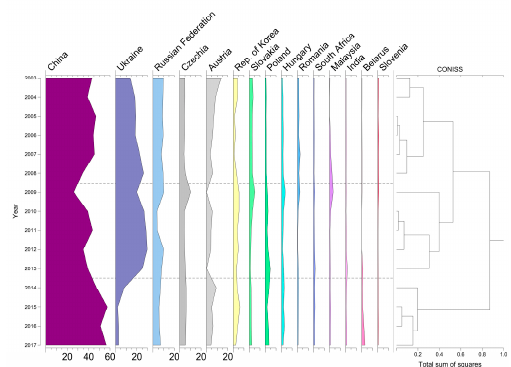
Figure 2. The fluctuation in the proportions of export volume and the clustering result (only the top 15 BRI exporters are listed above). Table 2. Three phases divided through the sequential clustering method.